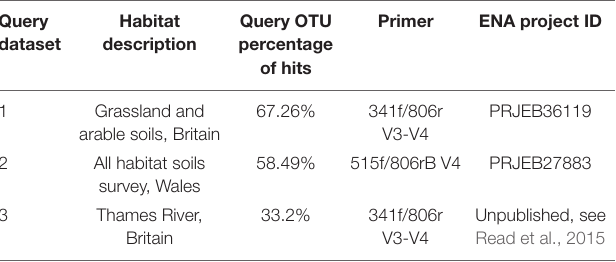
TABLE 1 | Validating the use of the CS OTU sequences as a database, through querying with independent datasets. Query dataset